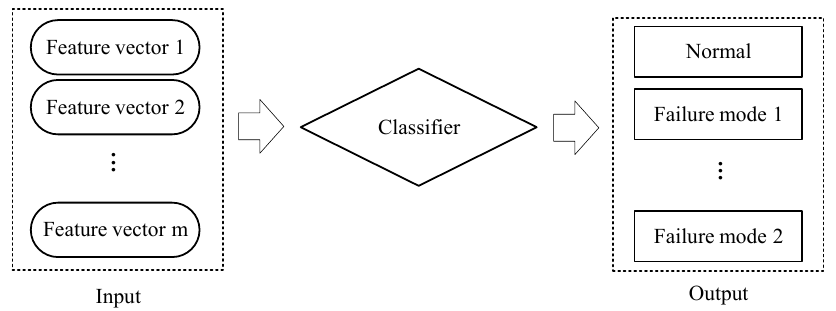
Figure 5. Learning model for classifying the state of equipment.